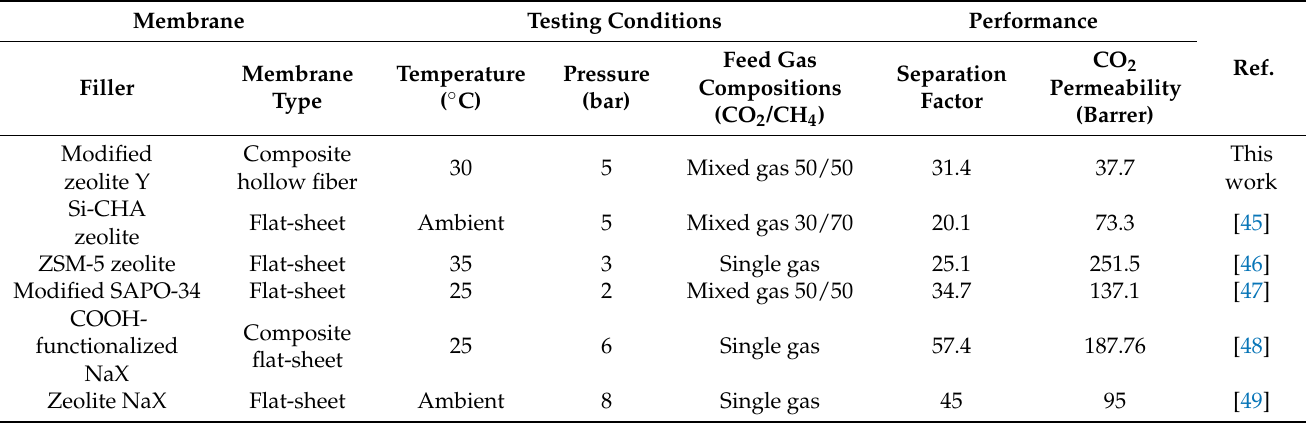
Table 3. Performance comparison of the membrane based on Pebax-1657 with different types of zeolite